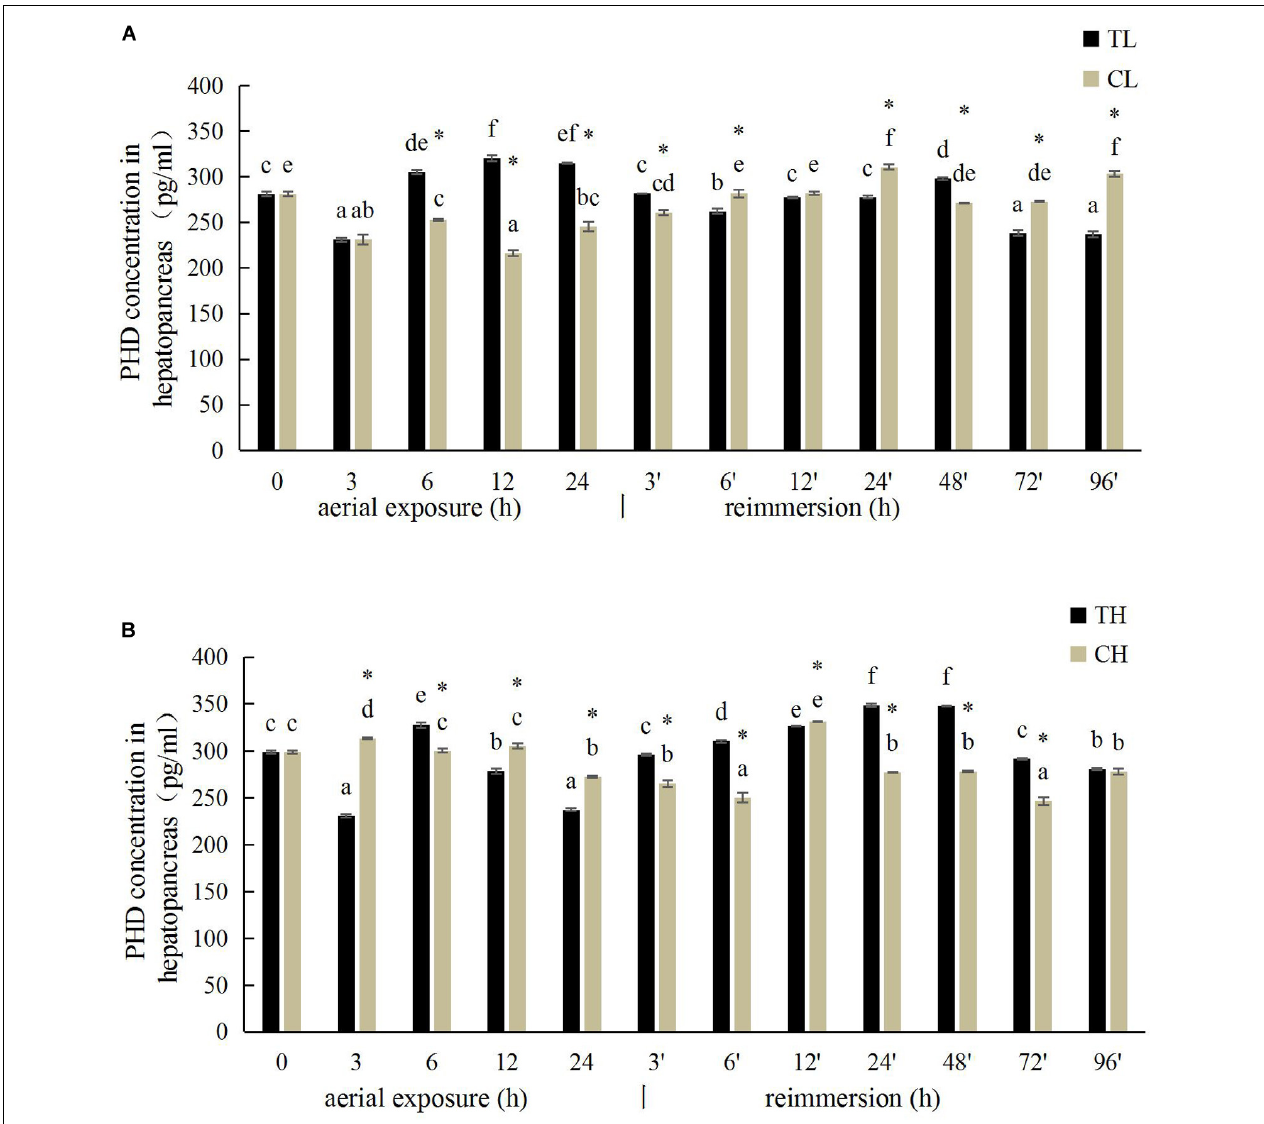
FIGURE 6 | Effects of aerial exposure on PHD in hepatopancreas of R. philippinarum under low temperature (A) and high temperature (B) .